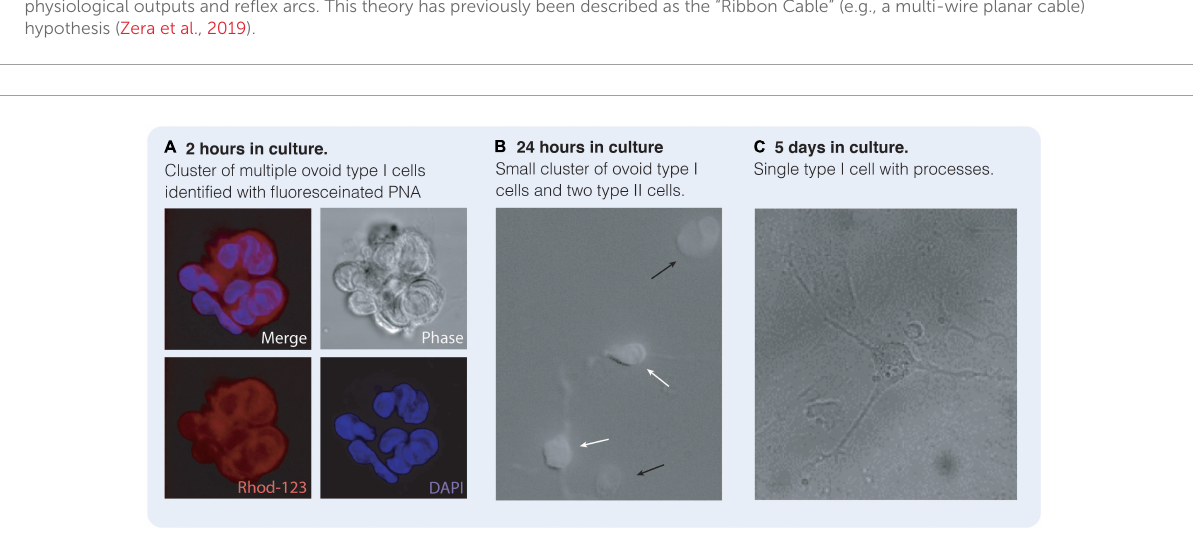
FIGURE4 Type I and type II cells in culture reminiscent of central nervous system (CNS) neurones and astrocytes. Carotid body type I cells may be identified by their affinity for Peanut Agglutinin (PNA) when labeled with a fluorescent marker such as Rhodamine-123 (Rhod-123). (A) Cluster of ovoid type I cells after 2 h in culture identified with PNA-labeled Rhod-123 and DAPI. (B) After 24 h in culture type I cells (black arrow) are still ovoid in shape. Type II cells (white arrows) are present with some processes and are astrocytic in nature. Type II cells are not PNA